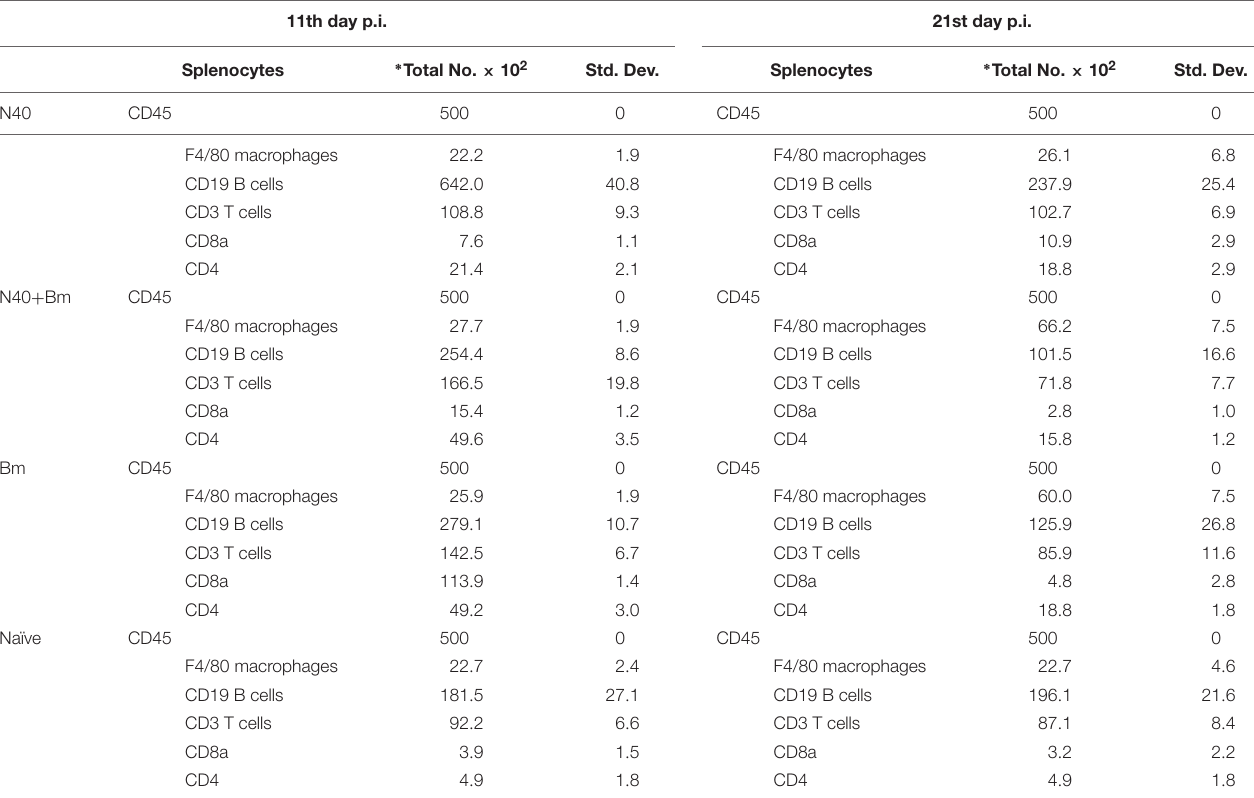
TABLE 3 | Analyses of splenic macrophage, B, and T cells by flow cytometry at 11th day and 21st day post-infection. 11th day p.i.